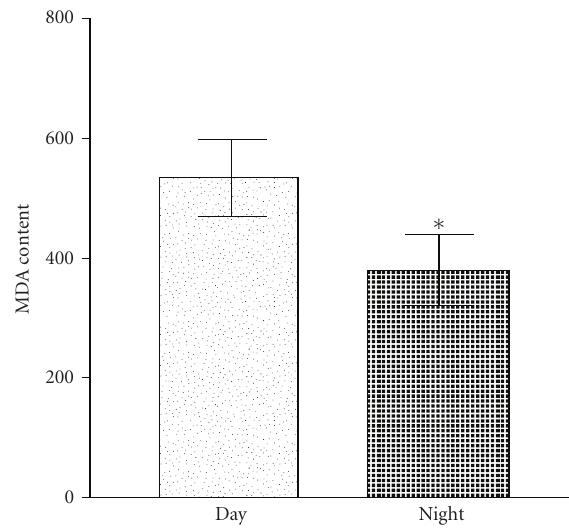
Figure 1: Day and night variation in malondialdehyde content in red blood cells. Significant decrease was observed in level of MDA in nocturnal samples ( ∗ P < . 05). MDA content is expressed as nanomoles per millilitres of packed